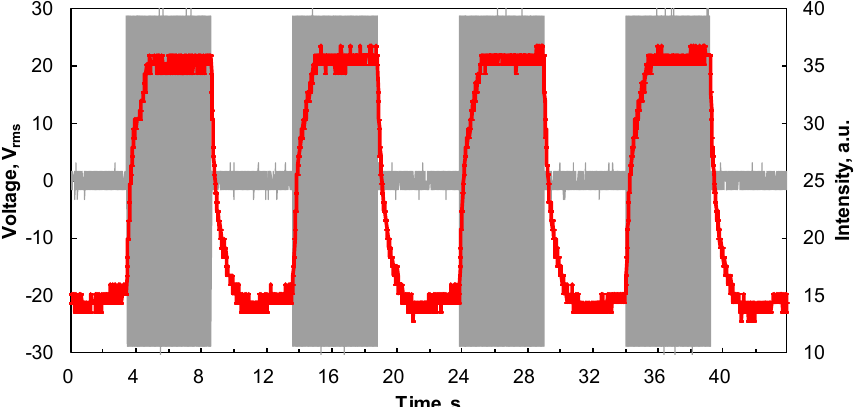
Figure 7. Dynamic response of the liquid lens impacted by voltage pulses.